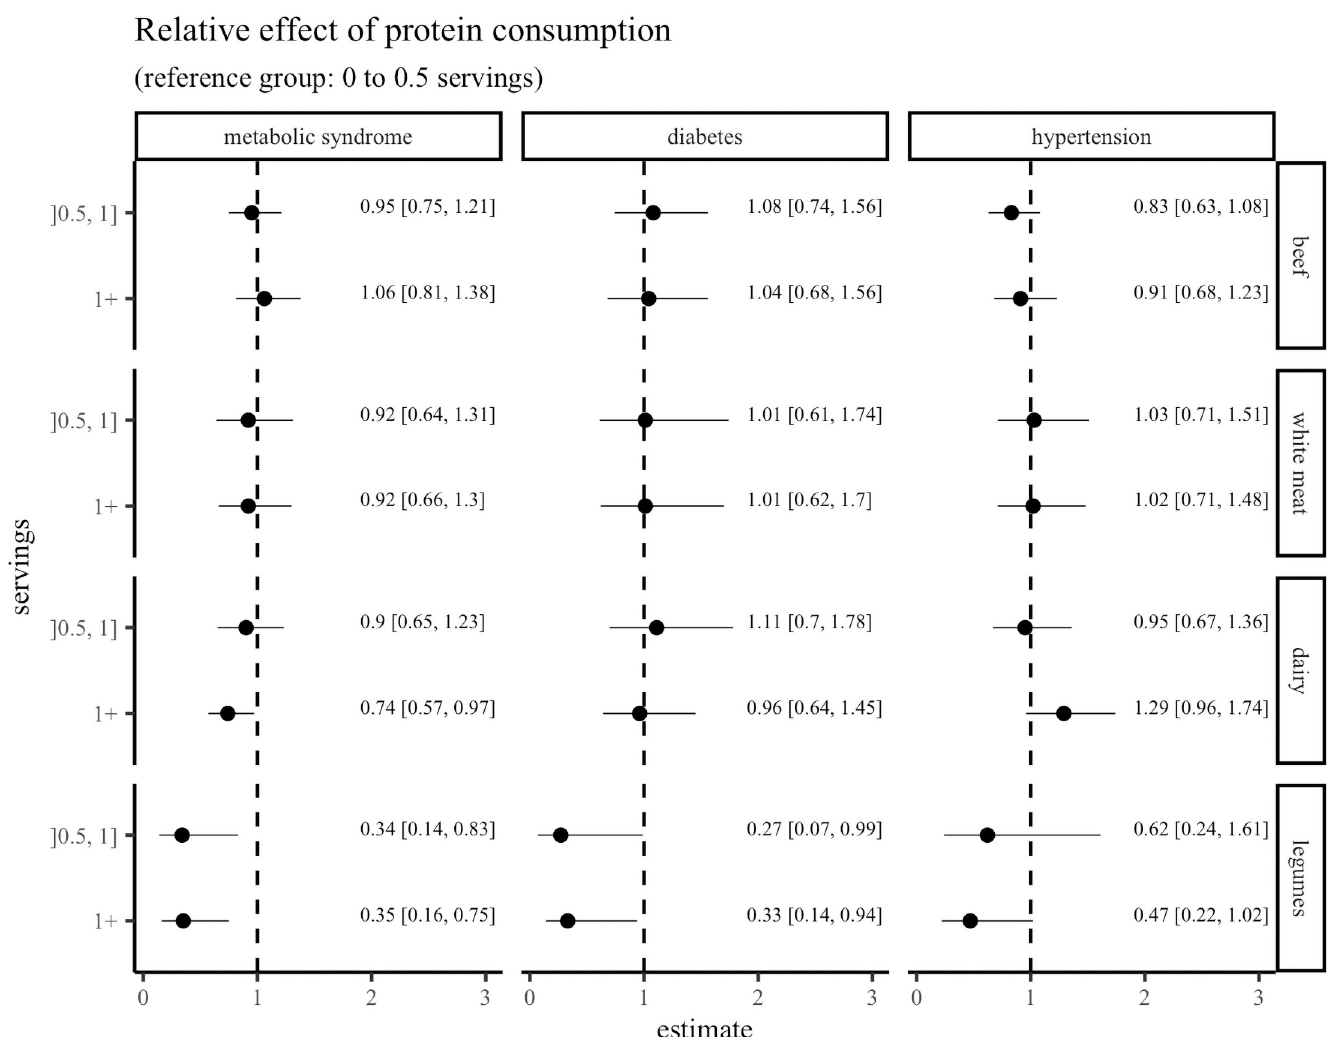
Fig 1. Association between consumption of protein- rich foods and metabolic syndrome, type-2 diabetes, and hypertension. Odds ratios with their 95% confidence intervals for each clinical condition are plotted for type and level of servings of foods. The logistic regression models used are adjusted for: sex, age, body mass index, waist to hip ratio, urban/rural residency, education, income, smoking and drinking habits, energy from diet (including carbonated beverages), physical activity. To analyze protein intake the following categories were used: low, � 0.5; moderate 0.51 to 1, and high > 1 serving per day; standard serving sizes (such as a glass of milk, a cup of yoghurt, or a slice of cheese) were assigned for dairy and 150 g for cooked legumes. The reference group considered for comparisons was the consumption of � 0.5 servings.